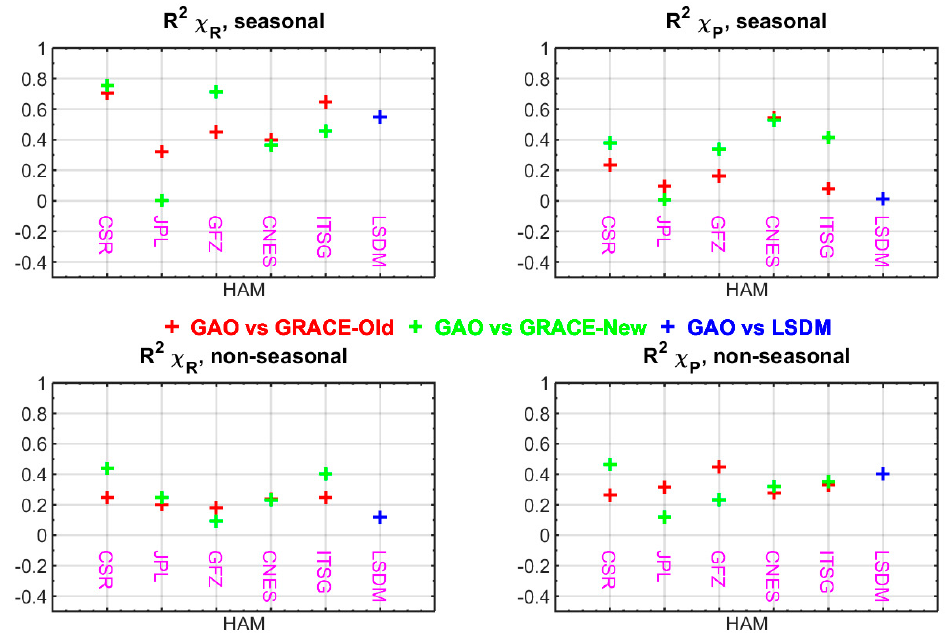
Figure 13. Coefficients of determination (R 2 ) for χ R and χ P parts of seasonal (top panel) and non-seasonal variation between GAO and HAM computed from GRACE solutions and the LSDM.